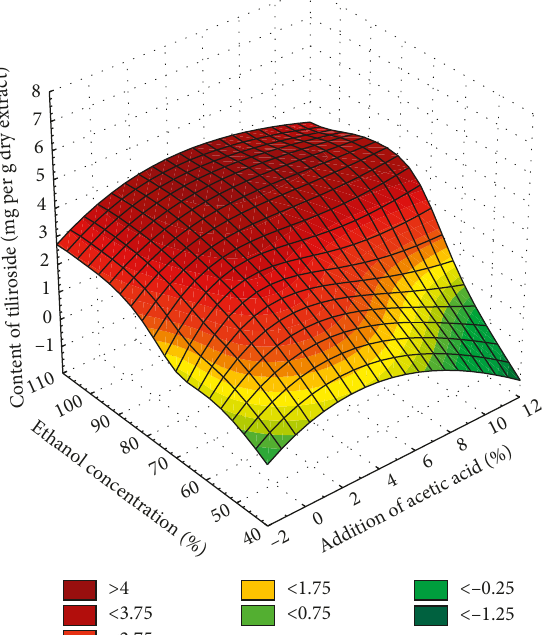
Figure 4: Surface chart 3W of the content of tiliroside vs. addition of acetic acid and ethanol concentration for all extraction methods (smoothing of smallest squares weighted by distance).